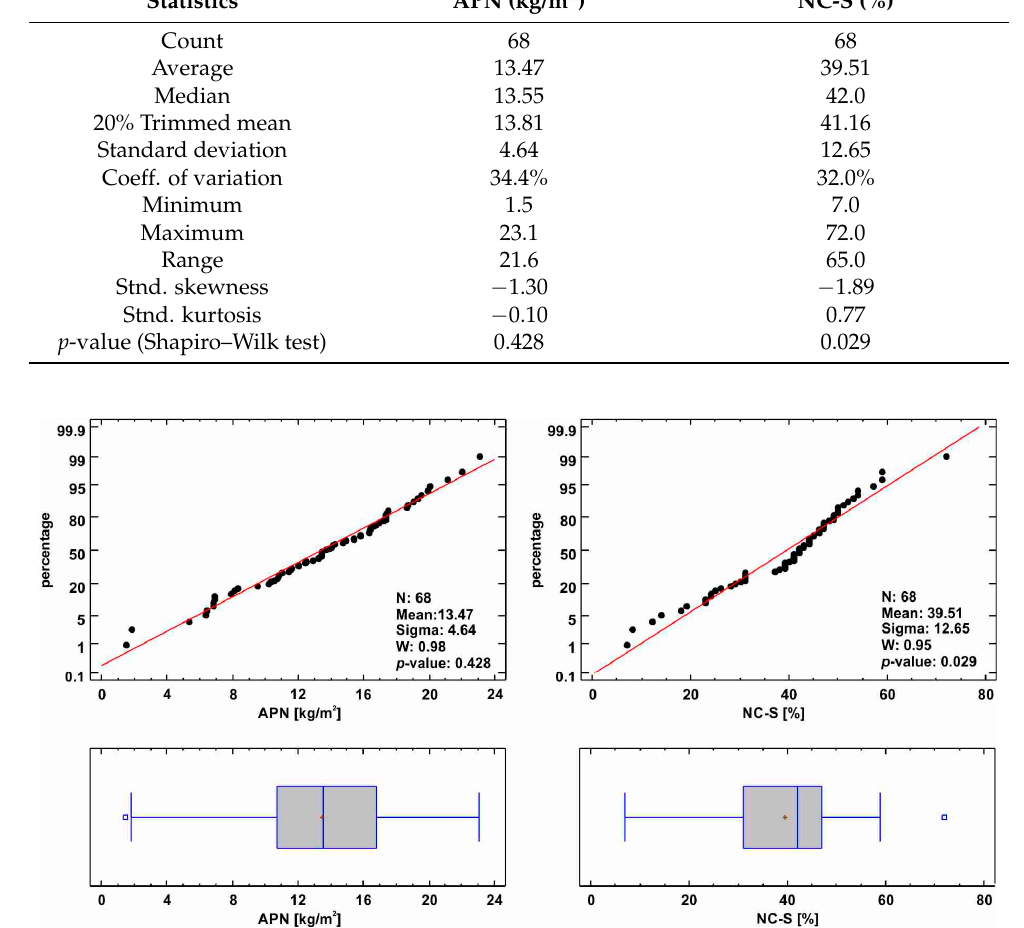
Figure 3. Normal probability plots (above) and box and whisker plots (below) for nodule abundance (APN) and nodule coverage of the bottom (NC-S).